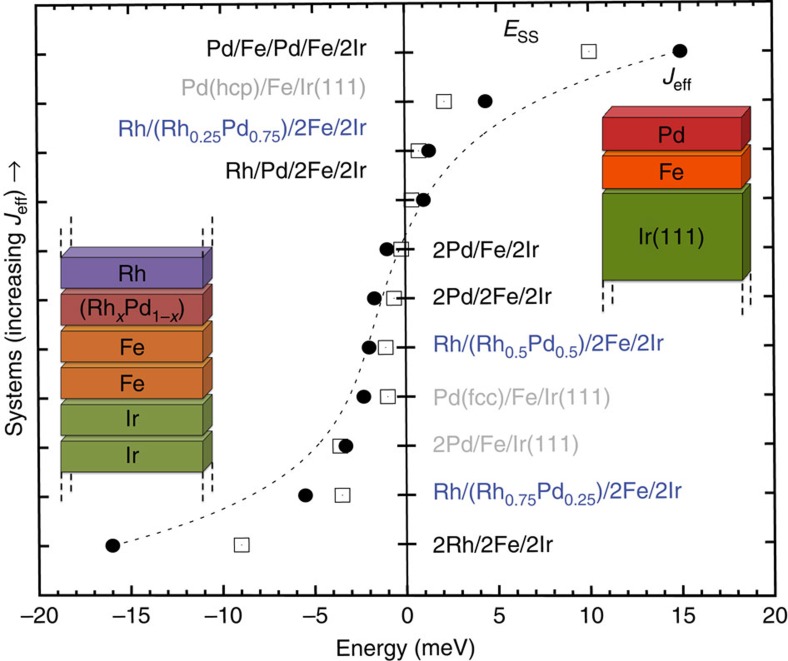
Effective exchange interaction in multilayers.Jeff (full circles) is given for TM multilayers (black/blue fonts) and ultra-thin films on surfaces (grey fonts). Insets show sketches of the multilayer and thin film geometry. The energy difference between a spin spiral with a wavelength of 2.7 nm with respect to the FM state, ESS, is given by empty squares. The dashed line is a guide for the eye.